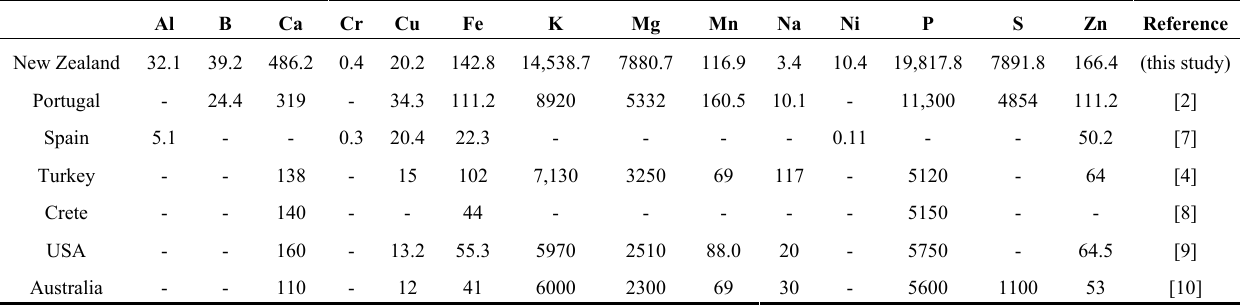
Table 2. Comparison of New Zealand grown Italian stone pine ( Pinus pinea ) mineral content (mg/kg) with published data from six different